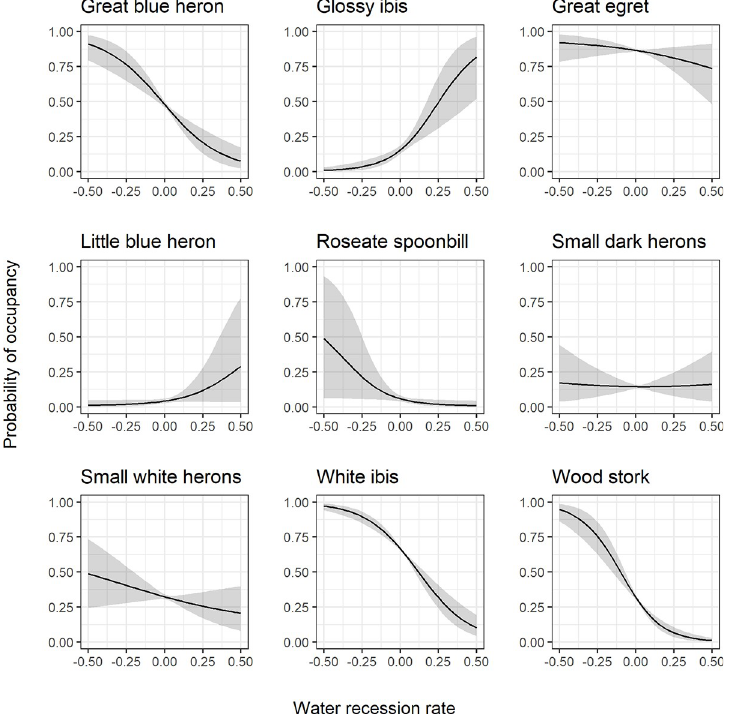
Fig 6. Water recession rate response curves. Species-specific relationships between probability of occupancy and average water recession rate during the breeding season (Jan 1 –June 30) from a fitted joint species distribution model of wading birds. Responses are calculated with all other model variables held at their mean. The black line represents the posterior mean and the gray shading represents the 95% posterior interval.